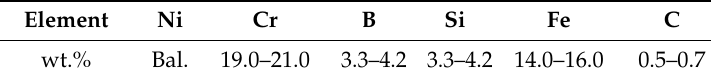
Figure 1. Morphology of mixing powders: ( a ) NiCrBSi–Ti; ( b ) NiCrBSi–WC/Co. Table 1. Chemical composition of NiCrBSi powder